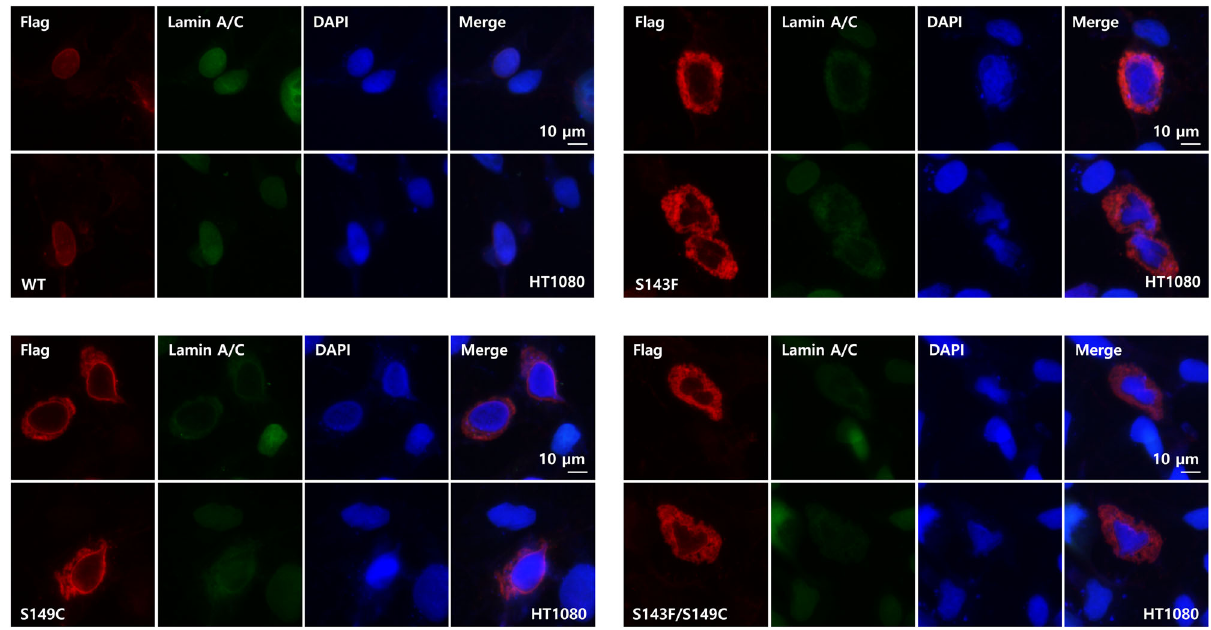
Fig. 6 Nuclear shapes and distribution of wild-type and S143F lamin A in HT1080 cells. Immuno fl uorescence assays were performed to visualize the nuclear morphology after the transfection of the vector overexpressing wild ‐ type or S143F Flag-tagged lamin A into HT1080 cells. For visualization of the nuclear membrane, cells were stained with an anti-Flag antibody for Flag-tagged lamin A (red), anti ‐ lamin A/C antibody for total lamin A/C (green), and DAPI for DNA (blue). The merged images of lamin A/C and DNA are displayed on the right (merge). Scale bar: 10 μ m.